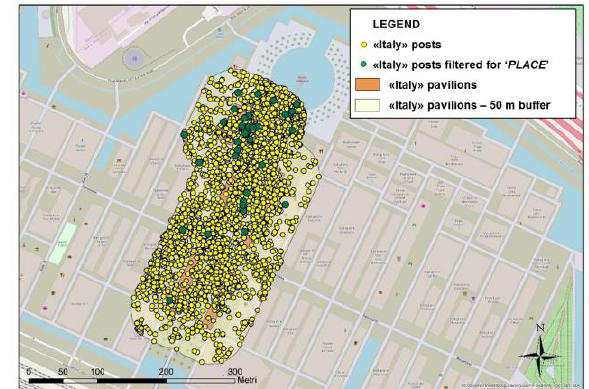
Figure 6. Example of results of the two-step Buffer-‘PLACE’ procedure for the semantic validation of the posts (case: Italy pavilions); green dots represent the validated posts